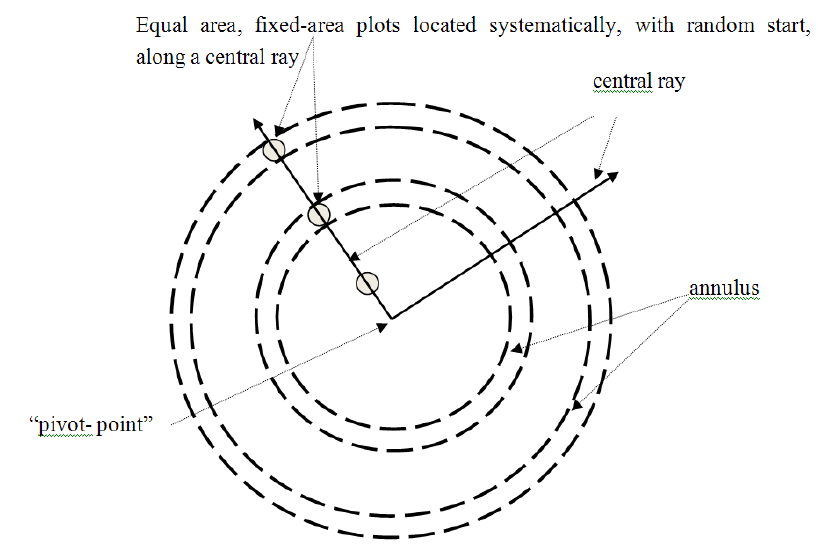
Figure 3. Sub-sampling sectors using fixed area plots.